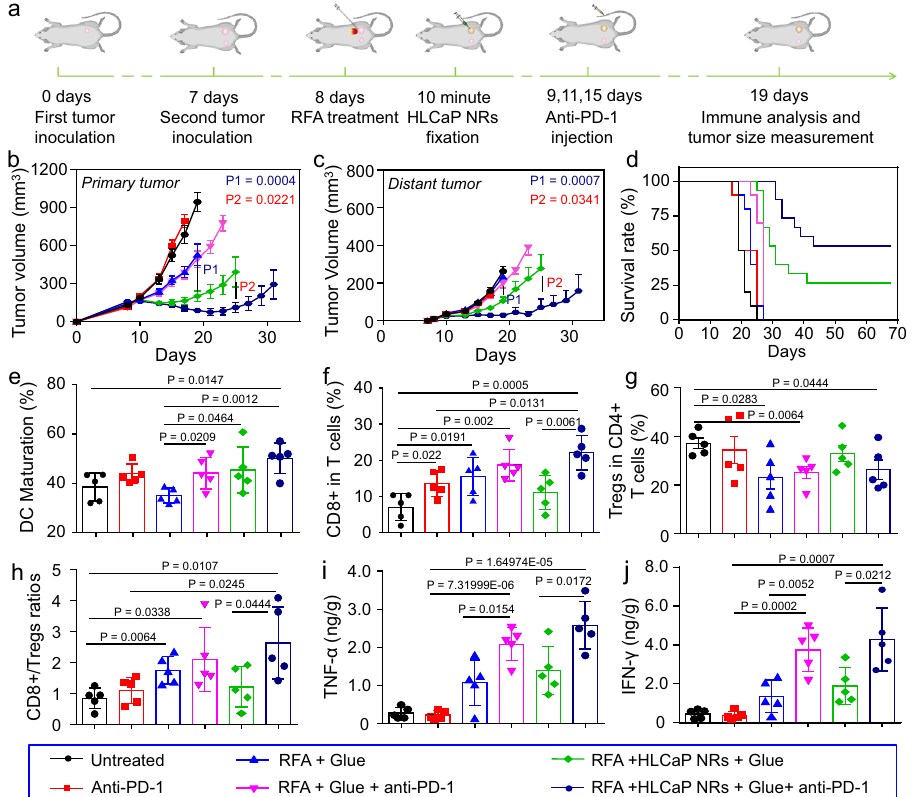
Fig. 6 In vivo antitumor study and corresponding immune mechanism study of combined RFA, HLCaP NRs fi xation, and anti-PD-1 immunotherapy. a Schematic illustration of the inoculation of the bilateral tumor model for in vivo antitumor and immune mechanism studies. b – d Tumor growth curves of primary ( b ) and distant tumors ( c ), as well as corresponding mobility-free survival rate ( d ) of mice with bilateral tumor models post different treatments as indicated. The mouse was set as dead when its tumor volume was larger than 1000 mm 3 . e DC maturation status in the drain lymph nodes adjacent to the primary tumors post various treatments as indicated. f – h The frequencies of CD3 + CD8 + T cells ( f ), and CD3 + CD4 + FoxP3 + Tregs ( g ), as well as their ratios ( h ) inside the distant tumors post various treatments as indicated. i , j The secretion levels of TNF- α and IFN- γ inside the distant tumors post various treatments as indicated. Data in Fig. b , c were represented as mean ± SEM, n = 10 or 15 biologically independent animals, data in Fig. e – j were represented as mean ± SD, n = 5 biologically independent animals. P values calculated by the two-tailed student ’ s t -test are indicated in the fi